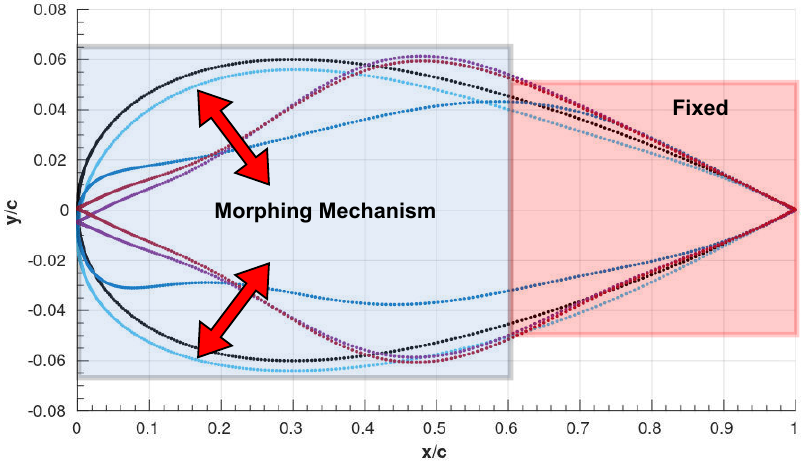
Figure 14. Final morphing